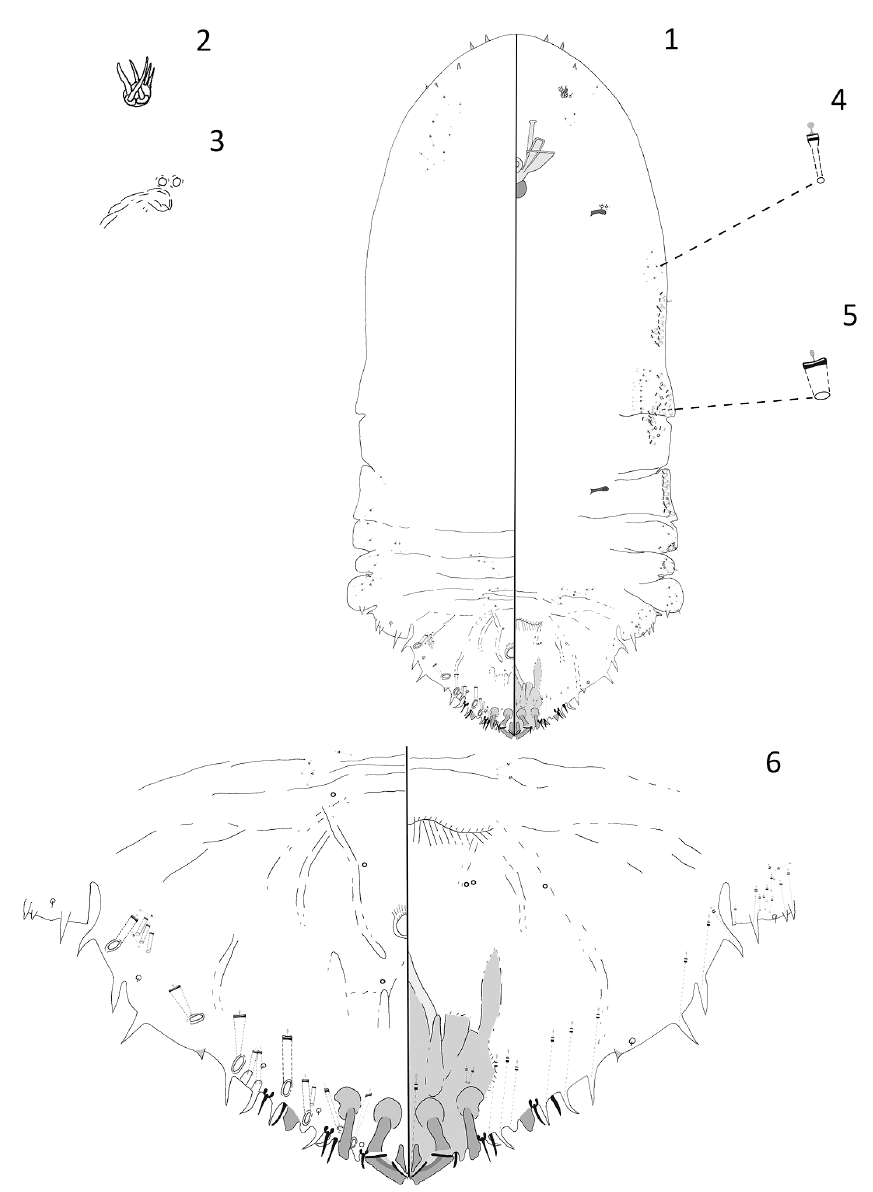
Figure 1–6. Andaspis brevicornuta Hamilton and Williams, sp. n., adult female; 1 whole body 2 antenna 3 anterior spiracle 4 microduct 5 macroduct 6 except for pygidium. A distinctive species with six spurs or minute horns present on anterior edge of head. Each antenna with five setae. Anterior spiracles each with 2 disc pores, each about 4 µm in diameter, trilocular; posterior spiracles lacking pores. An-